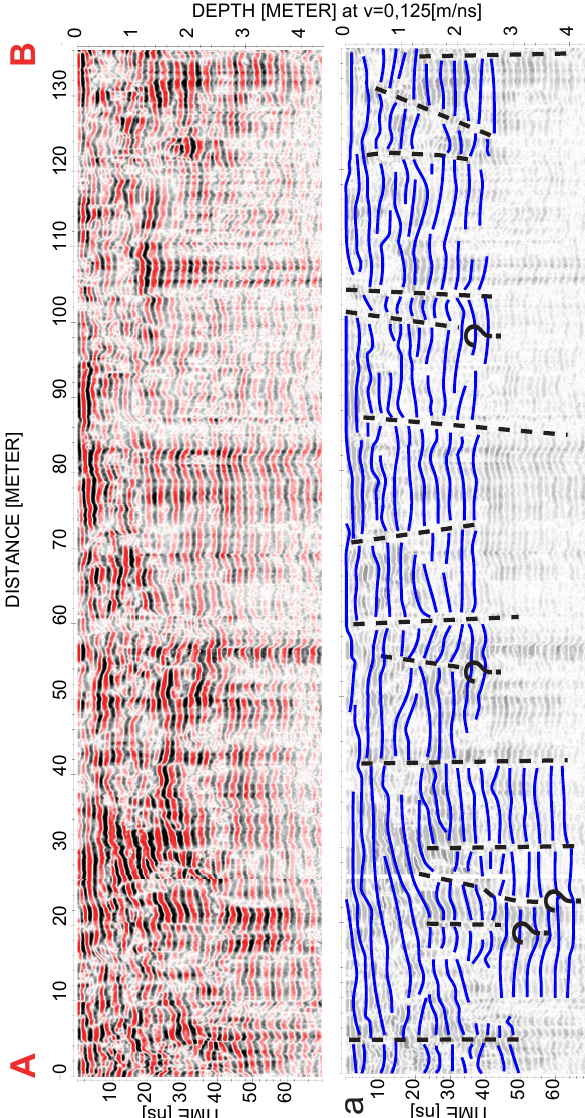
Figure 9. Radargram (a) and interpretation (b) of the WNW–ESE (red line) profile crossing through Devil’s Lane of the 400MHz an- tenna. Blue lines show interpreted reflectors; dashed lines represent interpreted faults. A number of faults appear in the profile, some of which do not reach the